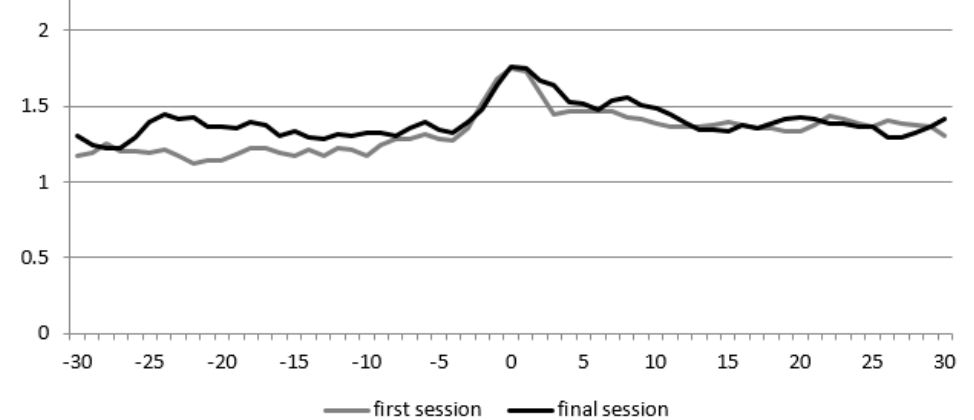
Figure 3. Diagonal Cross-Recurrence Profile (DCRP) of participant 2. The X-axis displays the delay in steps of 0.5 s, and the Y-axis the recurrence rate (the proportion of accurate turn-taking).